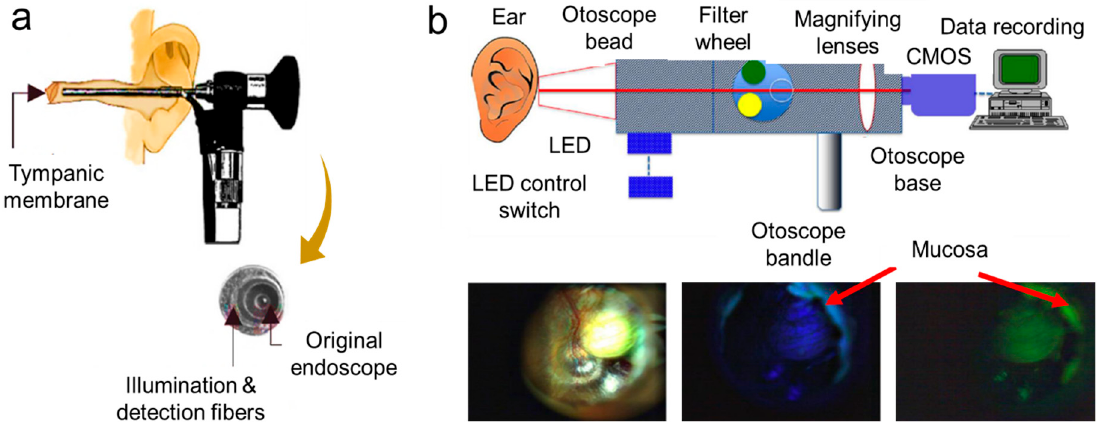
Figure 4. Tools available to detect middle ear infection. ( a ) Diffuse reflectance spectroscopy. Reproduced with permission from [68] . Copyright IOP Publishing, 2017. ( b ) Fluorescence otoscope. Reproduced with permission from [72] , Copyright American Chemical Society, 2014.